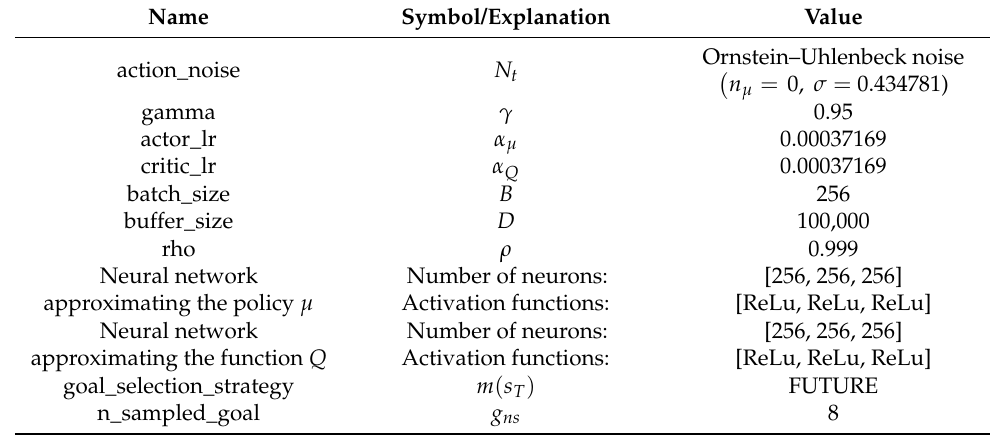
Table A1. Selected hyperparameters of RL-based algorithm to control the robotic